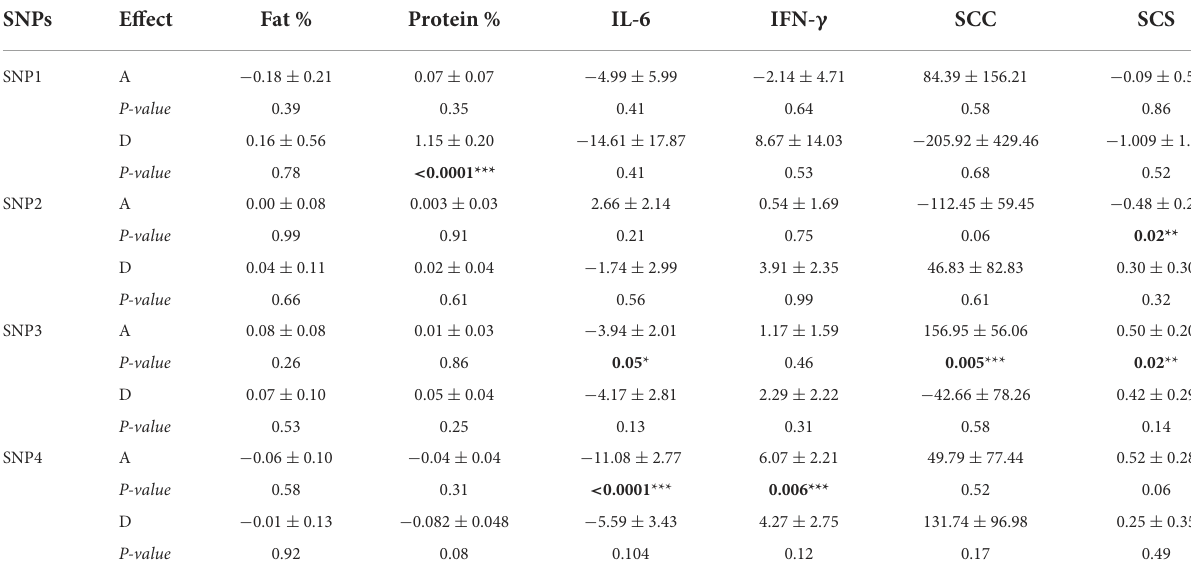
TABLE 4 Genetic effect of SNPs in TRAPPC9 and CD4 genes on milk production, mastitis resistance and serum cytokine traits in Chinese Holstein.